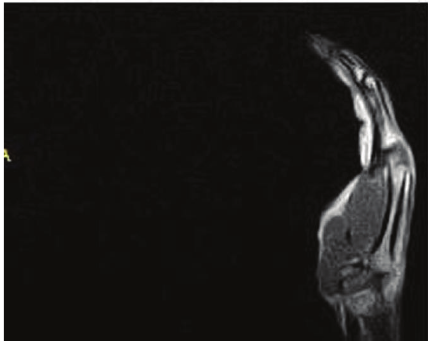
Figure 6: MR image of the volunteer without RFID tag attached to the wrist (imaging sequence: T 2 —Fast spin echo